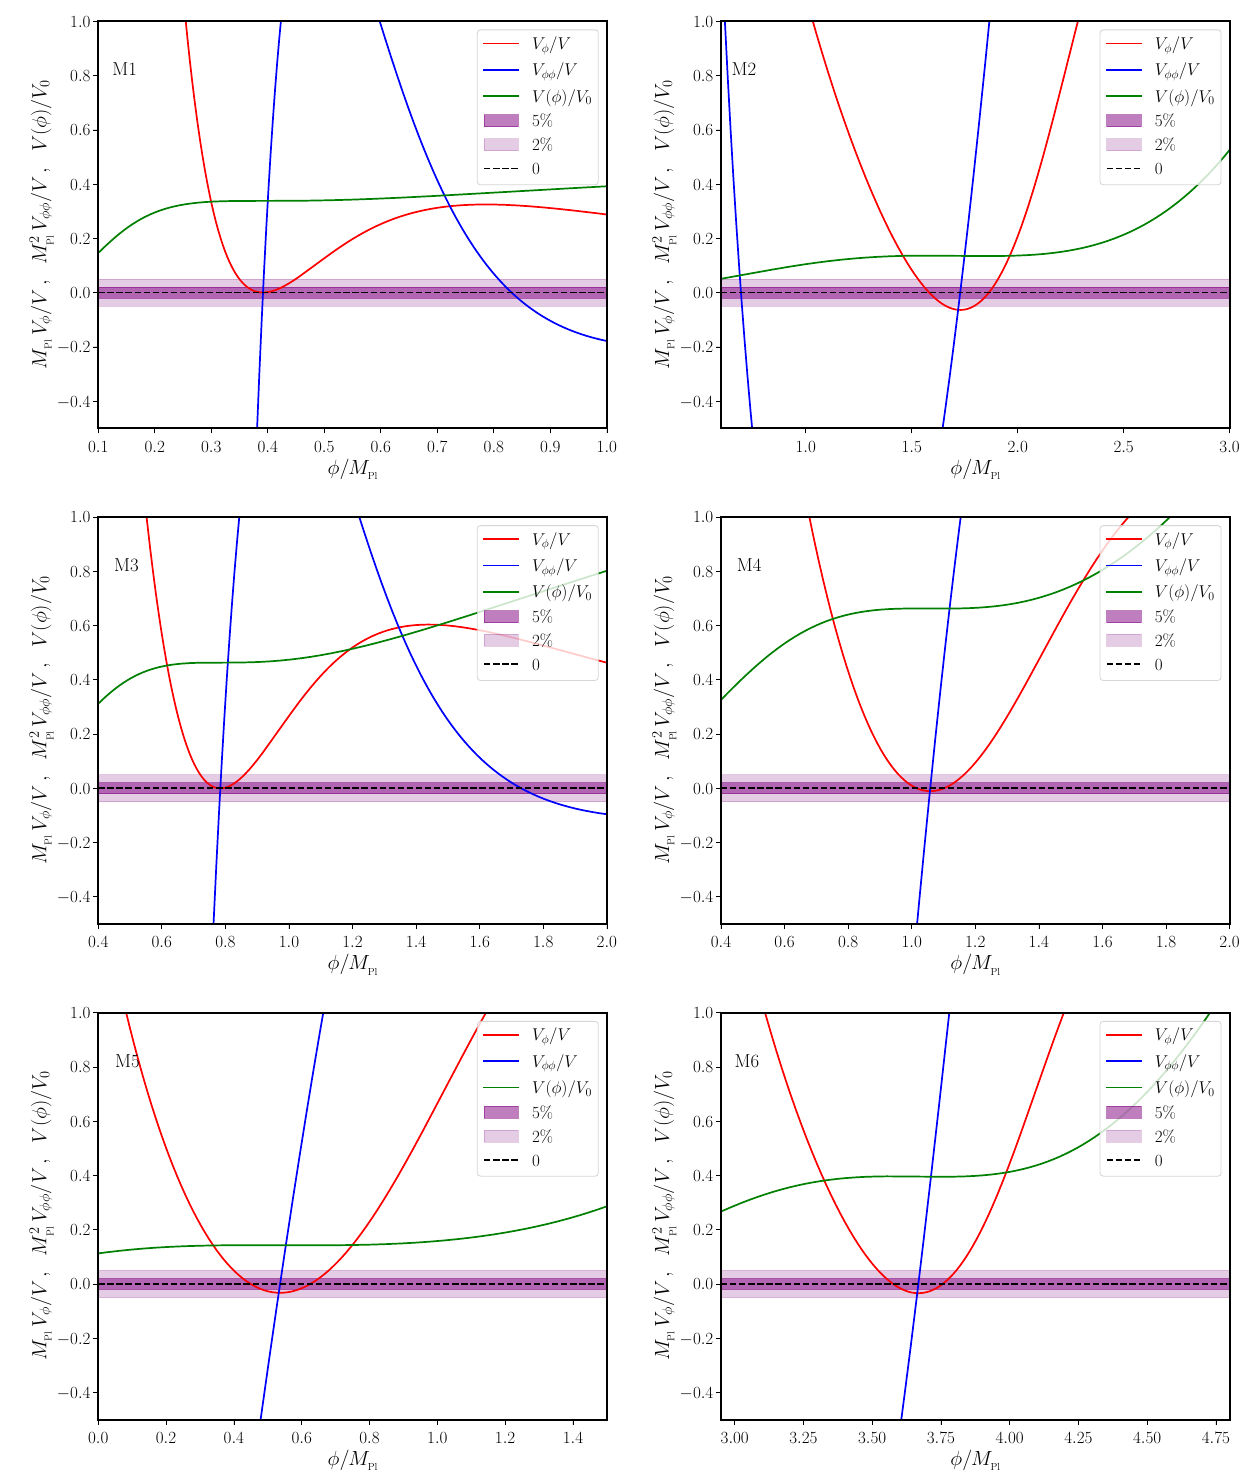
Figure A1. We have illustrated the manner in which we have numerically determined the points of inflection in the inflationary models of interest. We have plotted the quantities V φ / V and V φφ / V as well as a suitably rescaled potential V in the models M1 to M6 (from the top left to the bottom